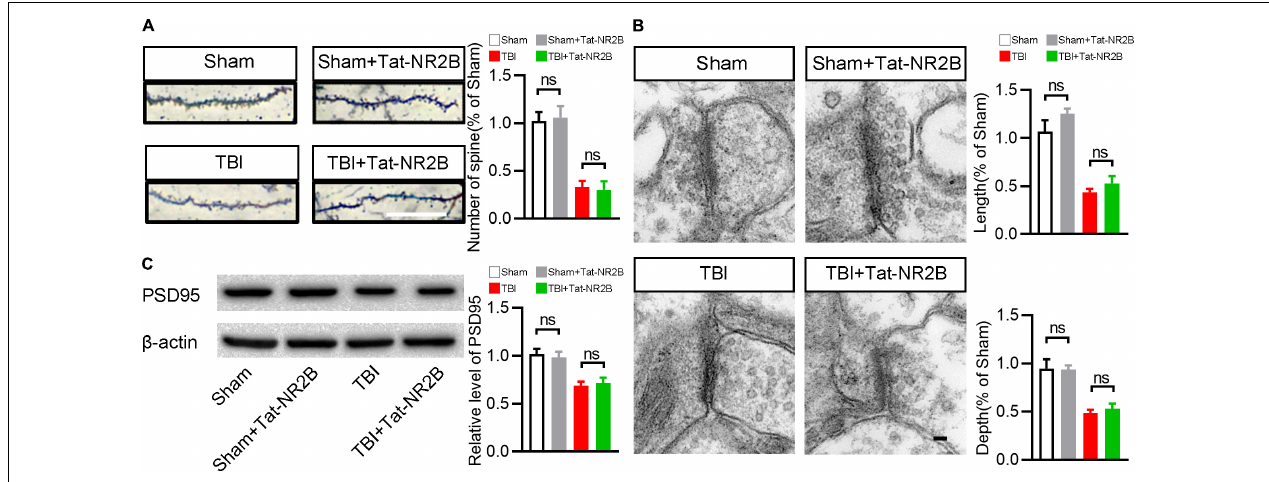
FIGURE 6 | Tat-NR2B didn’t affect the number and morphology of synapse. (A) Representative Golgi staining images and statistical analysis of dendritic spine number. Scale bar, 10 µ m. (B) Representative transmission electron microscope images and statistical analysis of length and depth of synapse. Scale bar, 100 nm. (C) Western blotting analysis of the expression levels of PSD95. n = 6 for each group; ns, no significance; Values are presented as the mean ±